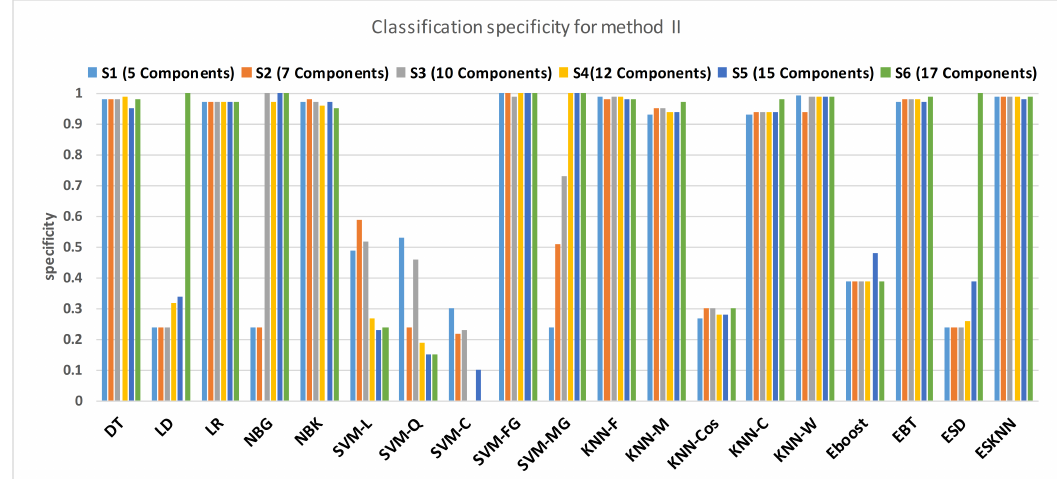
Figure 17. Performance of specificity for different feature sets in various classifiers for PuPG signal through method II.